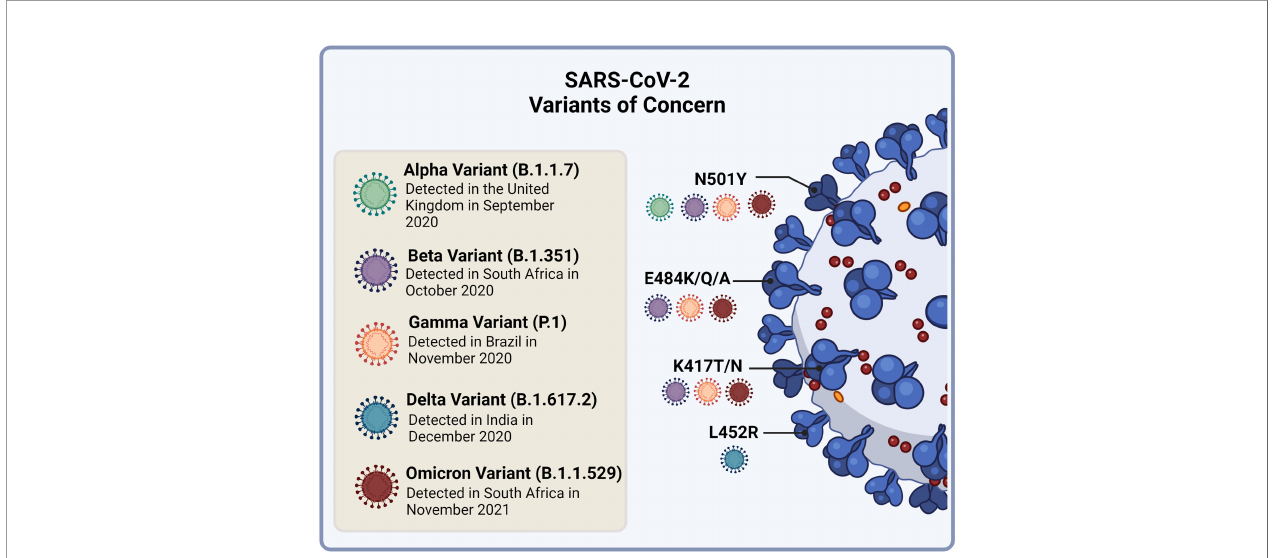
FIGURE 5 | Currently circulating SARS-CoV-2 variants of concern and their receptor binding domain (RBD) amino acid substitutions of interest to virulence and immune evasion. The N501Y substitution is common to the Alpha, Beta, Gamma and Omicron variant strains. The E484K/Q/A and K417T/N substitutions are present in the Beta, Gamma and Omicron strains, while the L452R substitution is unique to the Delta variant. Image created by PM using BioRender (https://